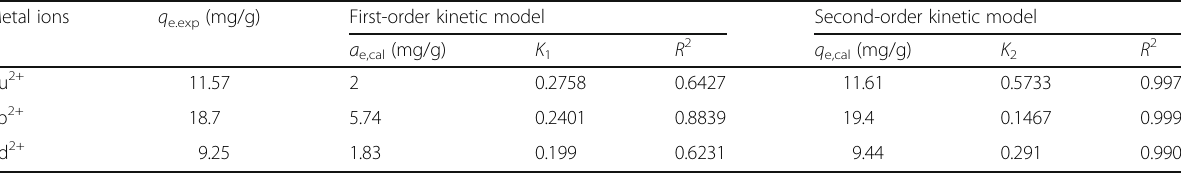
Table 3 Kinetic parameters and correlation coefficients of the two kinetic equations on c-MCM-41(40) Metal ions q e.exp